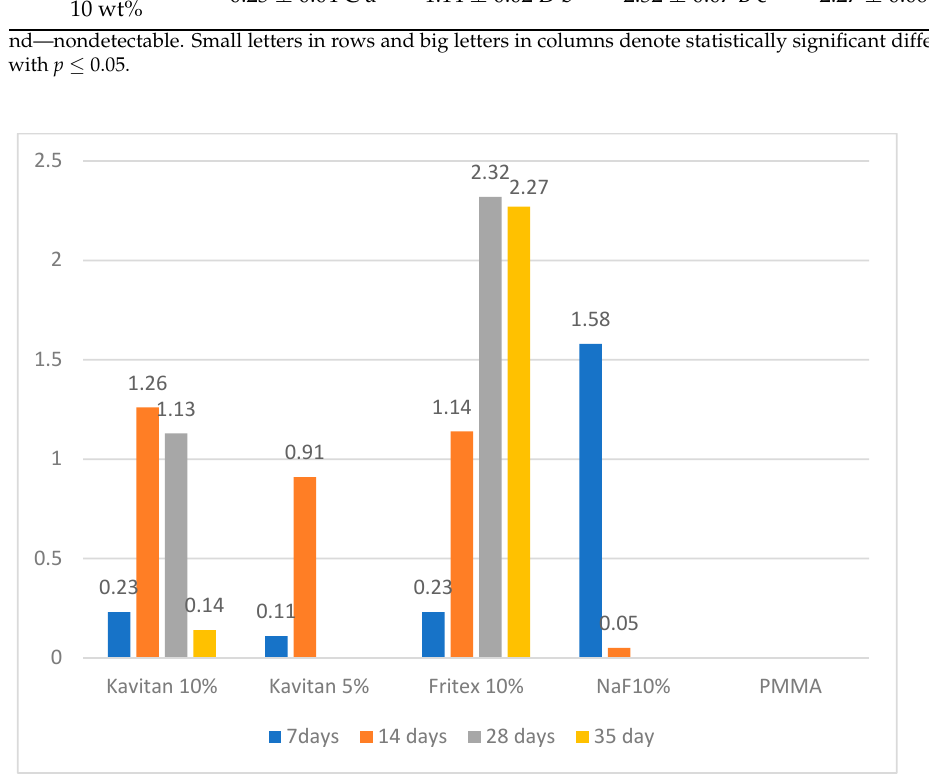
Figure 2 . Fluoride release with time of storage. Figure 2. Fluoride release with time of storage. Table 4. Mean values ± SD of fluoride release after recharge ( µ g/cm 2